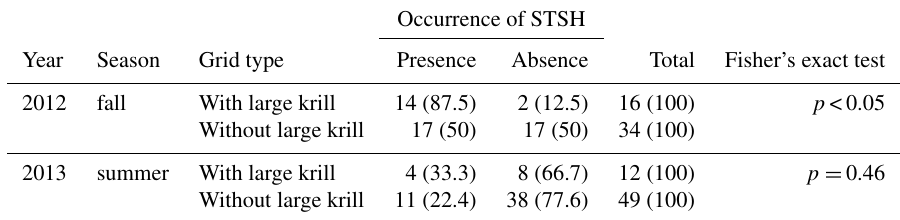
Table 5. The occurrence (and percentage occurrence) of short-tailed shearwaters ( Ardenna tenuirostris , STSH) in 50km 2 grids with and without large krill (>8.0mm total length) in fall (September) 2012 and summer (June–July) 2013. The results of Fisher’s exact tests are also